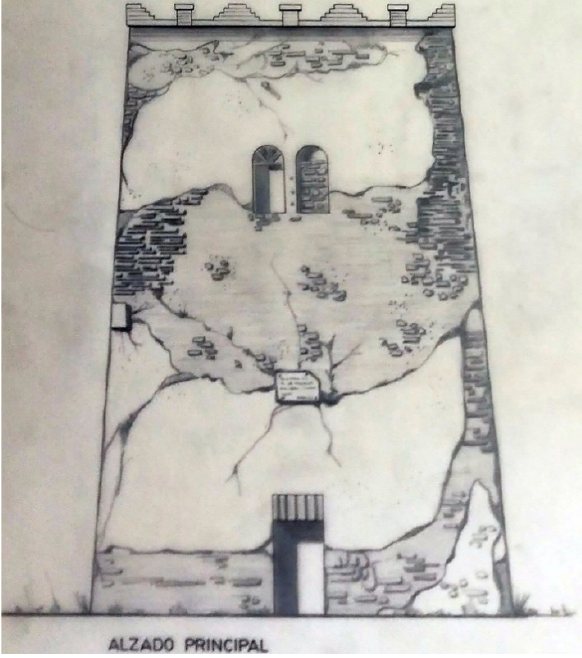
Figure 2. South Elevation of Negro Tower. Hand-made scale drawing. (Cartagena,